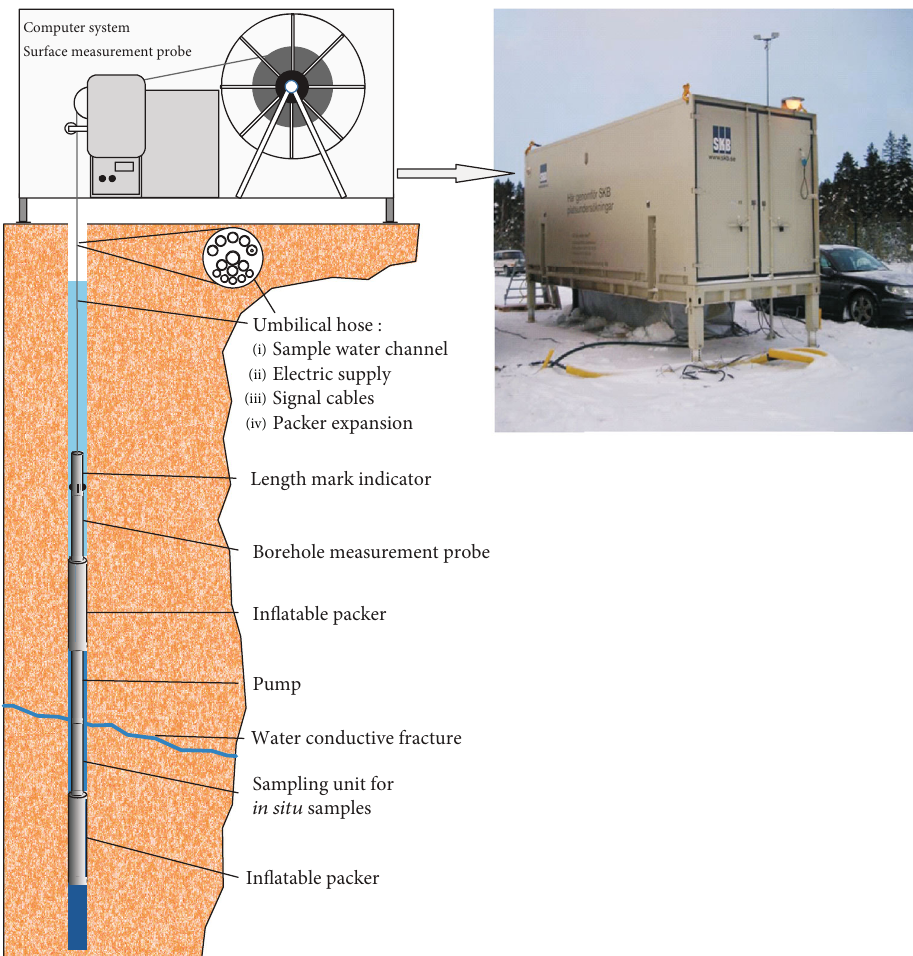
Figure 3: Outline of the integrated system comprising a carriage/container with downhole equipment (umbilical hose, in fl atable packers, pump, downhole measurement probe, and downhole sampling unit) and facilities for lowering and raising this equipment. This system is placed over the borehole (see photo), and the container ’ s indoor temperature is adjusted to maintain the temperature of the groundwater in the section to be